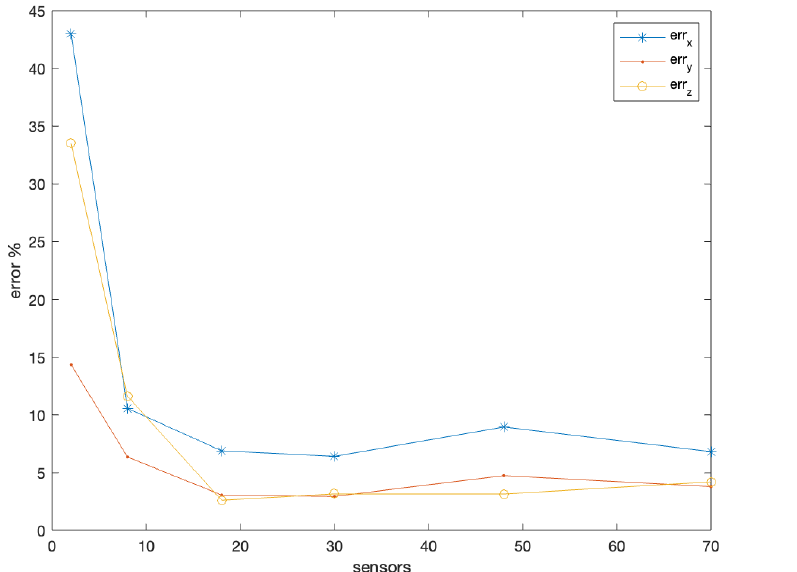
(cid:13) (cid:13) (cid:13) (cid:16) (cid:13) (cid:17) Ref (cid:13) (cid:13) (cid:13) (cid:13) Corr − U Ref / in percentage, with x , y , z x , y , z (cid:13) (cid:13) U (cid:13) (cid:13) U x , y , z 2 2